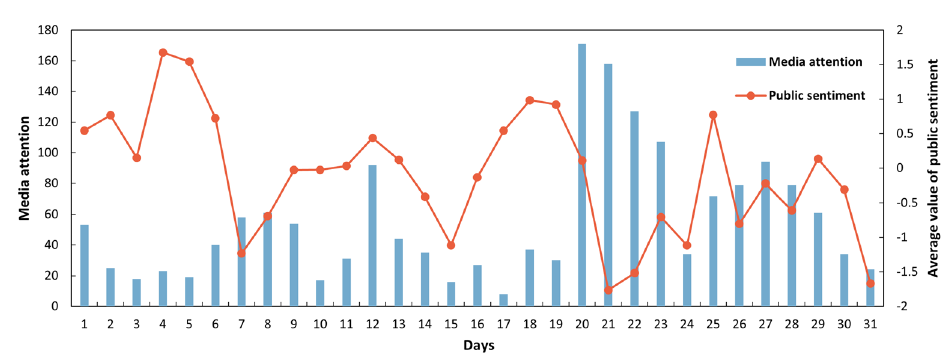
Figure 7. Example of daily news media responses towards urban floods, i.e., heavy rainstorms in Hebi in July